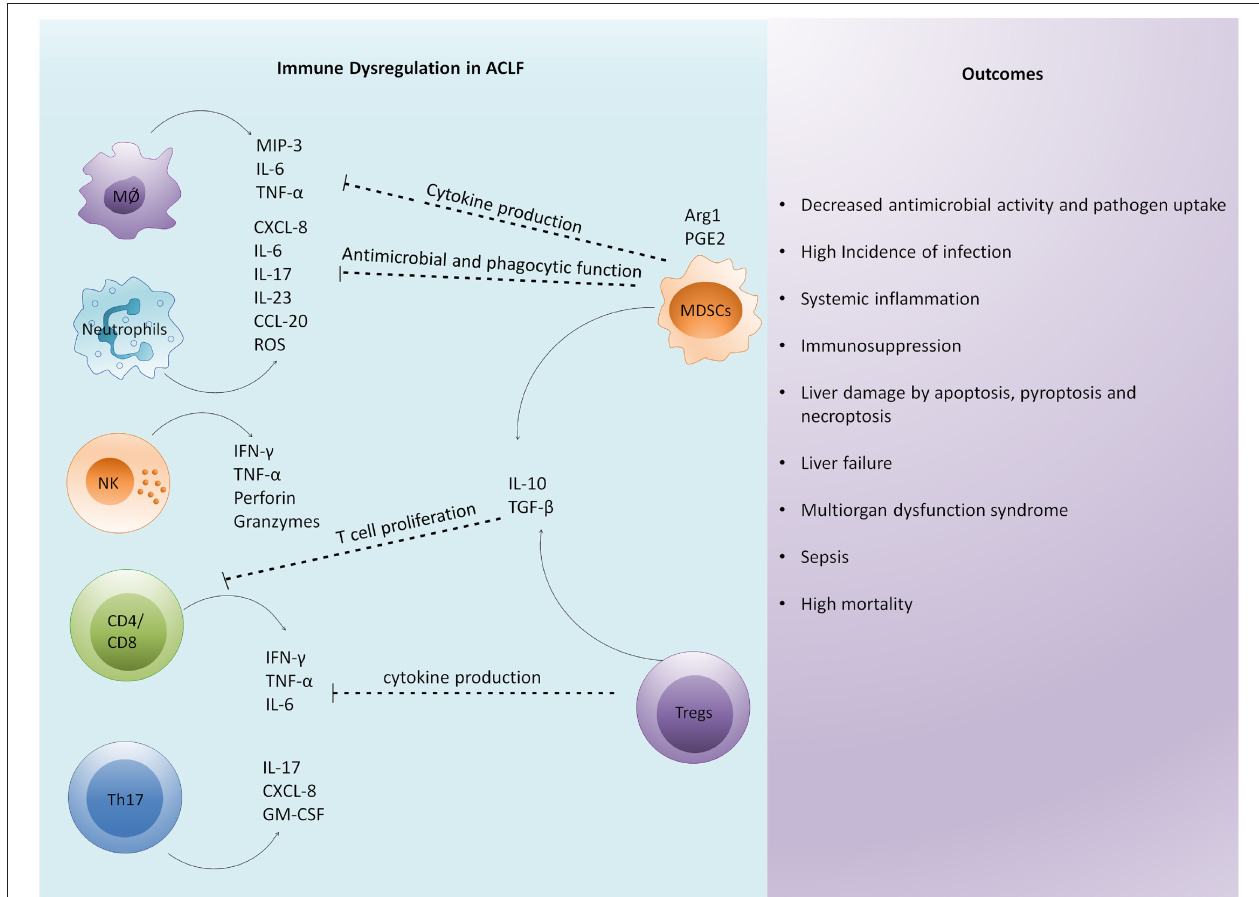
FIGURE 2 | Immune dysregulation is a critical factor in the pathophysiology of ACLF. Excessive immune activation drives systemic and intrahepatic cytokine storms in patients with ACLF leading to inflammation. Enormous cytokine secretion in the liver results in the infiltration of circulating immune cells that further induce hepatic damage. Subsequently, an antiinflammatory response is generated to control excessive inflammation. However, excessive antiinflammatory response by regulatory cells impairs the function of other immune cells by inhibiting their antimicrobial and phagocytic activities, cytokine secretion, and T cell proliferation. The overall immune dysregulation increases the risk of infection and sepsis development. In addition, it induces distinct cell death related pathways in the liver, causing multiorgan dysfunction leading to high mortality. MØ, macrophage; NK cells, natural killer cells; MIP-3, macrophage inflammatory protein; TNF- α , tumor necrosis factor- α ; IFN- γ , interferon- γ ; ROS, reactive oxygen species; GM-CSF, granulocyte macrophage colony stimulating factor; Arg1, arginase-1; PGE2, prostaglandin E2; MDSC, myeloid derived suppressor cells; Tregs, regulatory T cells; TGF- β , transforming growth factor- β .